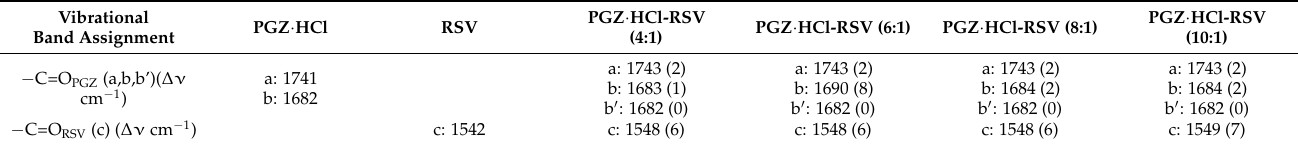
Table 7. Grain morphology of the solid forms (1:1, 1:6, 1:10, 6:1, and 10:1).